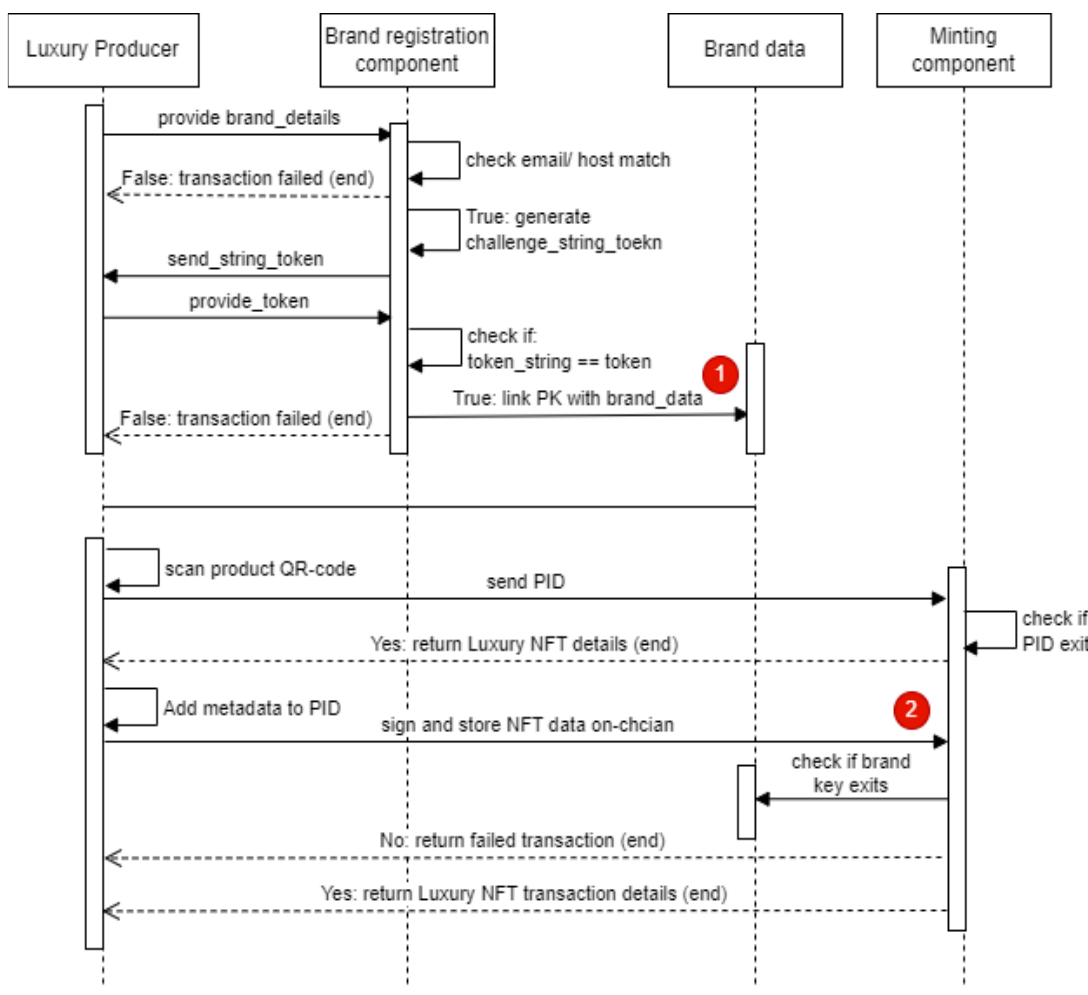
Figure 6. Brand registration and NFT minting sequence.